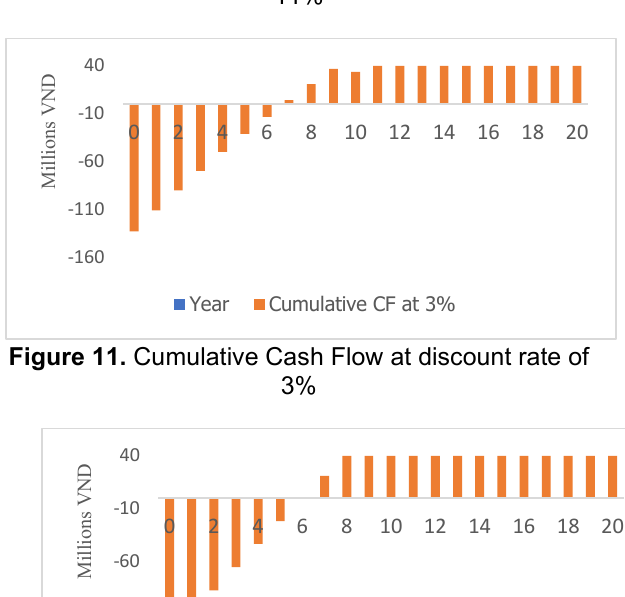
Figure 10. Cumulative Cash Flow at discount rate of